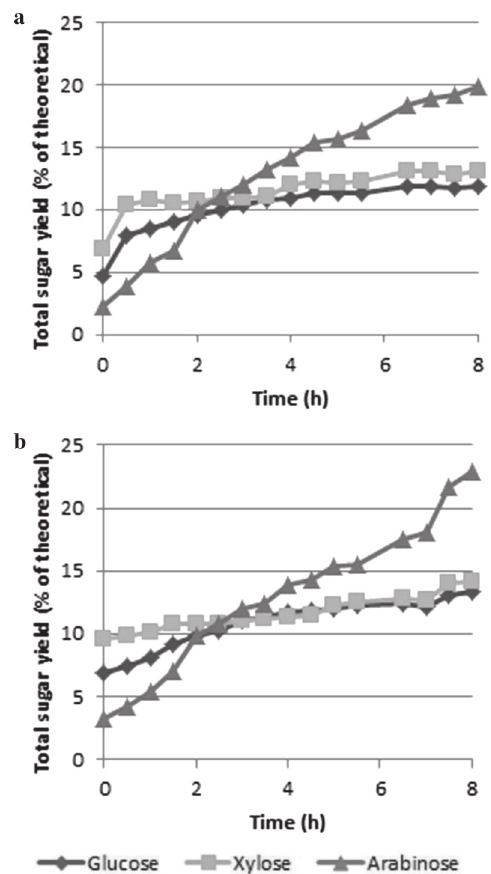
Fig. 1 – Arabinose removing pre-hydrolysis at 90 °C and 7 % (w/w) dry matter using 0.2 % (w/w) sulfuric acid (a), and arabinose removing pre-hydrolysis at 90 °C and 7 % (w/w) dry matter using 0.2 % (w/w) sulfuric acid after 24 hours soaking of the raw material in the acidic liquid